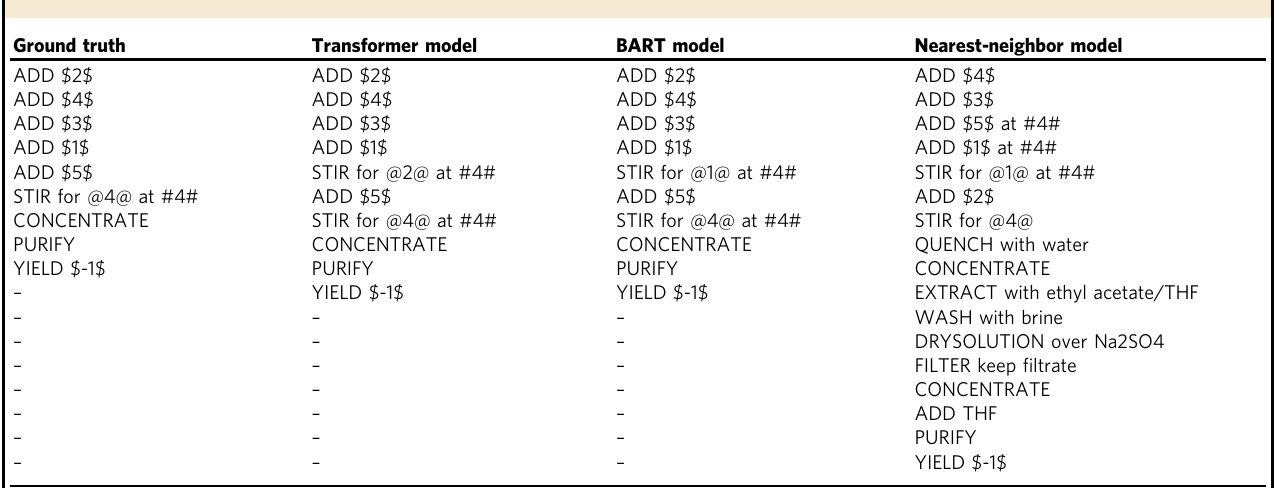
Table 4 Action sequences predicted for a reaction from the test